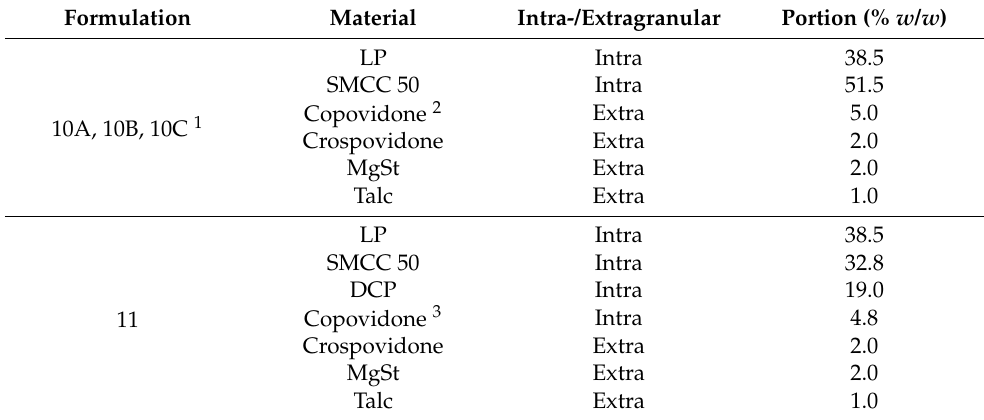
Table 3. Overview of formulations of development step III. LP = losartan potassium; MgSt = magnesium stearate; SMCC = silicified microcrystalline